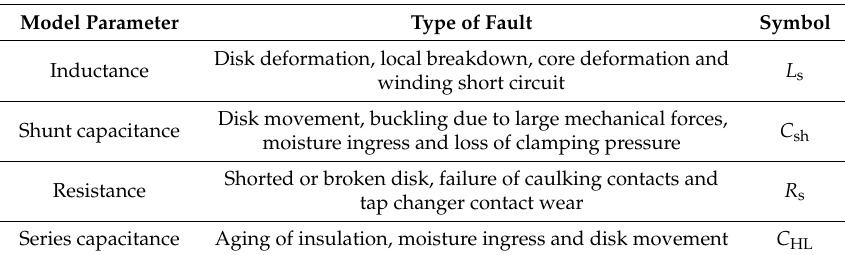
Table 2. Model parameters and mechanical faults.